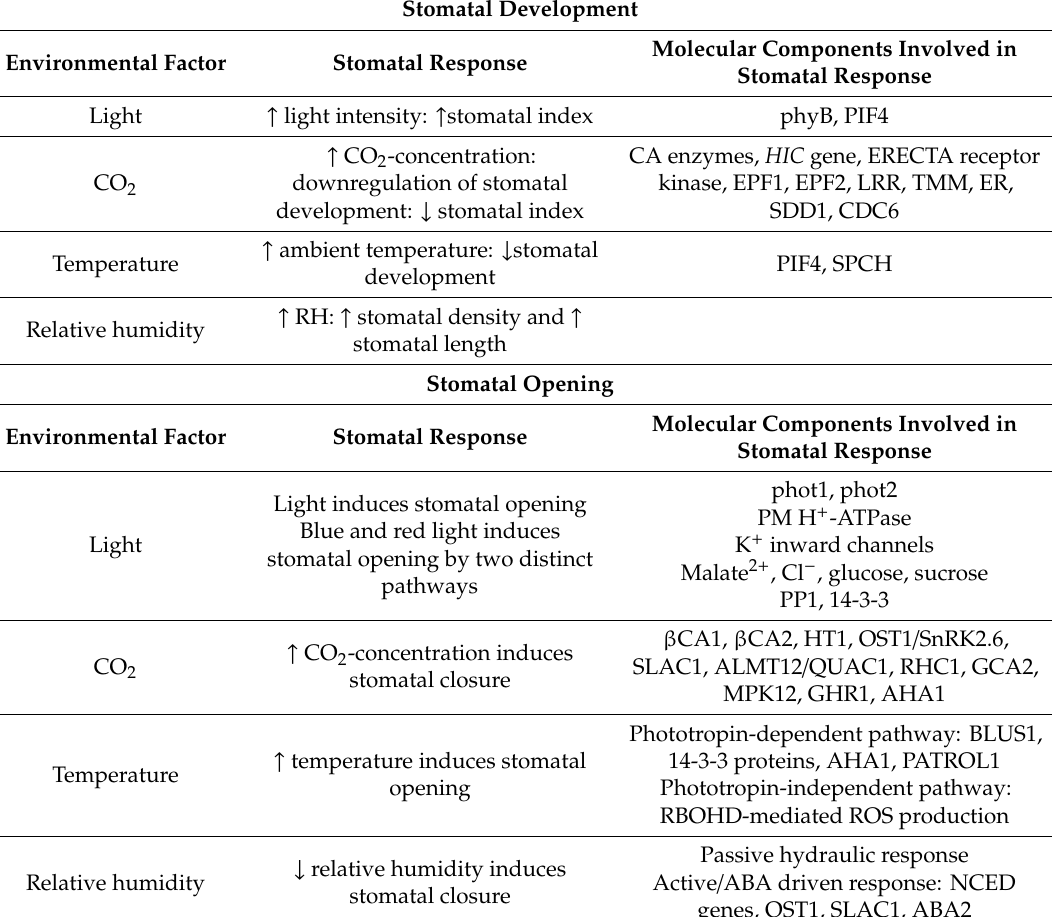
Table 1. Summary of the influence of the environmental factors light, CO 2 , temperature, and relative humidity on stomatal development and opening, including the molecular components involved in this stomatal